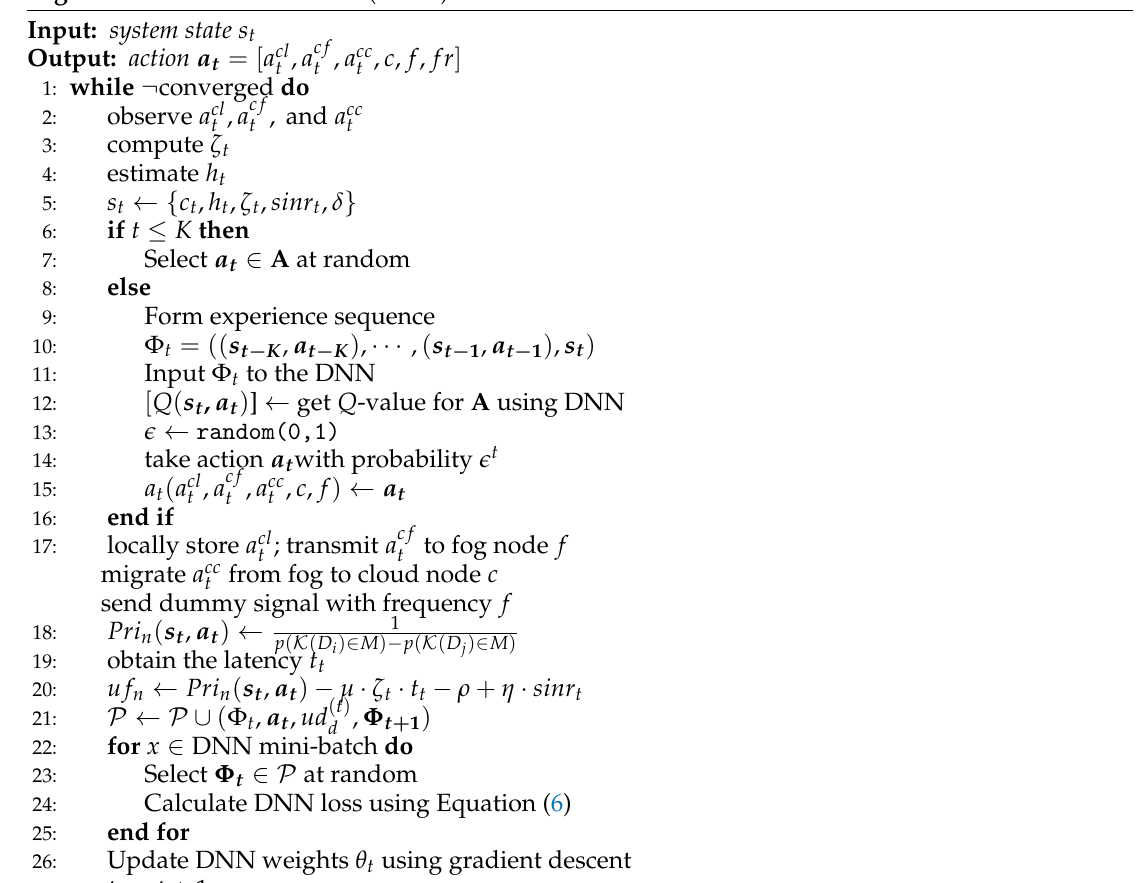
Algorithm 2 Network Module